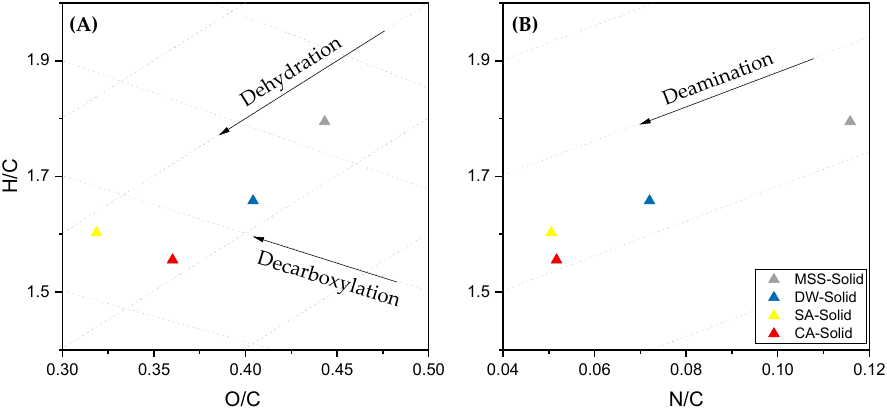
Figure 3. Van Krevelen diagram of MSS and the solids prepared by hydrothermal pre-treatment, ( A ) O/C vs. H/C ratio and ( B ) N/C vs. H/C ratio. As shown in Table 1, the amount of crude lipids is increased from 21.7 wt. % in MSS up to 29 wt. % in SA-solid. Again, both acidic pre-treatments here show the biggest effect. The lipid content increased congruently with the solubilization of organic matter in the aqueous phase. This could be explained by a favored extraction of proteins and carbohy- drates. Bougrier et al. and Li et al. reported negligible or even no influence on the solubil- ity of lipids, even with moderately elevated temperatures [44,54]. Furthermore, the signif- icant higher H/C eff value of the pre-treated solids can be referred to its lipid content, as lipids are primarily composed of fatty acids with long-chain –(CH 2 ) n – units that contain much fewer heteroatoms than carbohydrates and proteins. In Table 1 the ash composition of the MSS and the DW, SA and CA solids is given in terms of the main inorganic elements. The pre-treatment with DW shows no effect on the composition, while SA and CA substantially leached calcium (Ca), iron (Fe), magnesium (Mg), and phosphor (P). The Ca amount in the SA solid needs to be mentioned, as it was not as effectively removed as in the CA solid. With regard to the sulfur content from the elemental analysis, this suggests the precipitation with sulphate (SO 42 − ), supplied from the SA, to form calcium sulphate (CaSO 4 ). This would explain why the ash is not reduced. Here it needs to be notified, that the subsequent water washing step was not able to re- move all acidic residues, especially when using SA [55]. In summary, the pre-treatment with CA removed most of the inorganic constituents, while DW only solubilizes organic matter. 3.2. Effect of Pre-Treatment on the Yield and the Elemental Composition of HTL-Products The obtained solids from the pre-treatment step were again hydrothermally pro- cessed at fixed temperature, reaction time and solid load of 350 °C and 30 min and 15 wt.